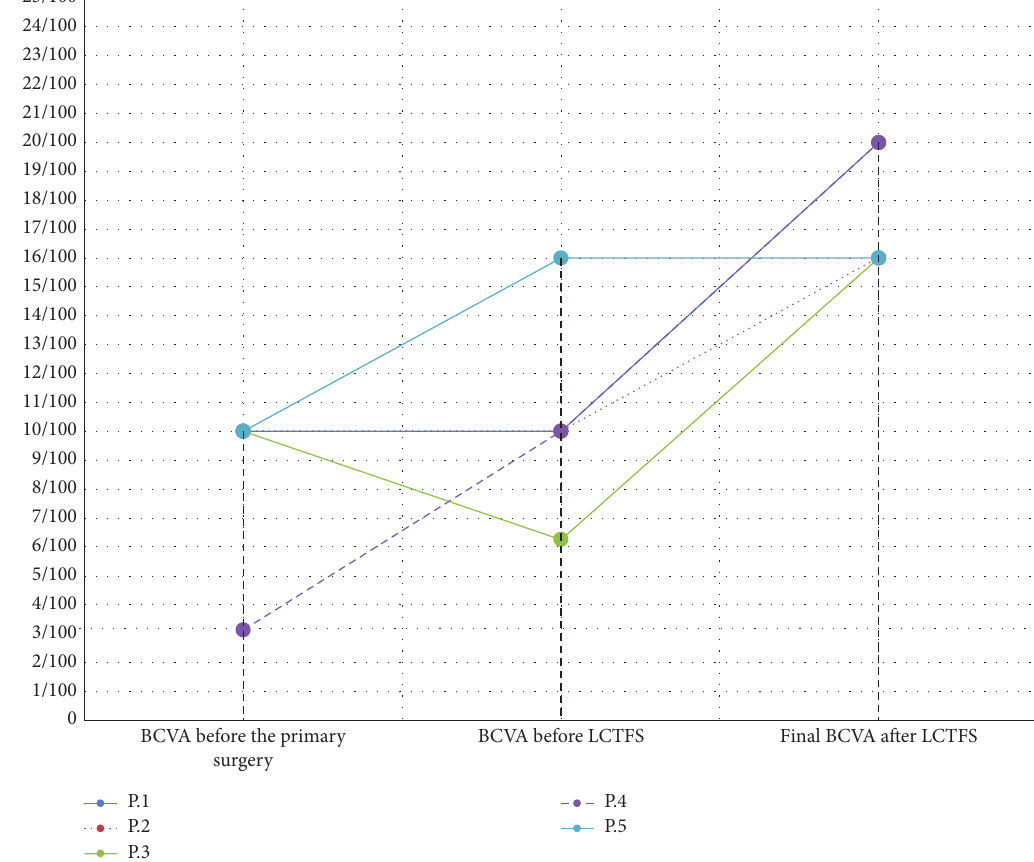
Figure 3: Changes in the BCVA from baseline to 18 months after the surgery.